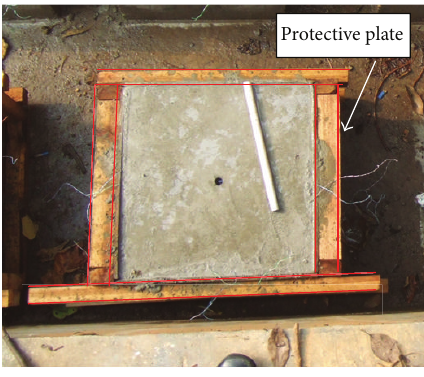
Figure 1: Concrete test model.